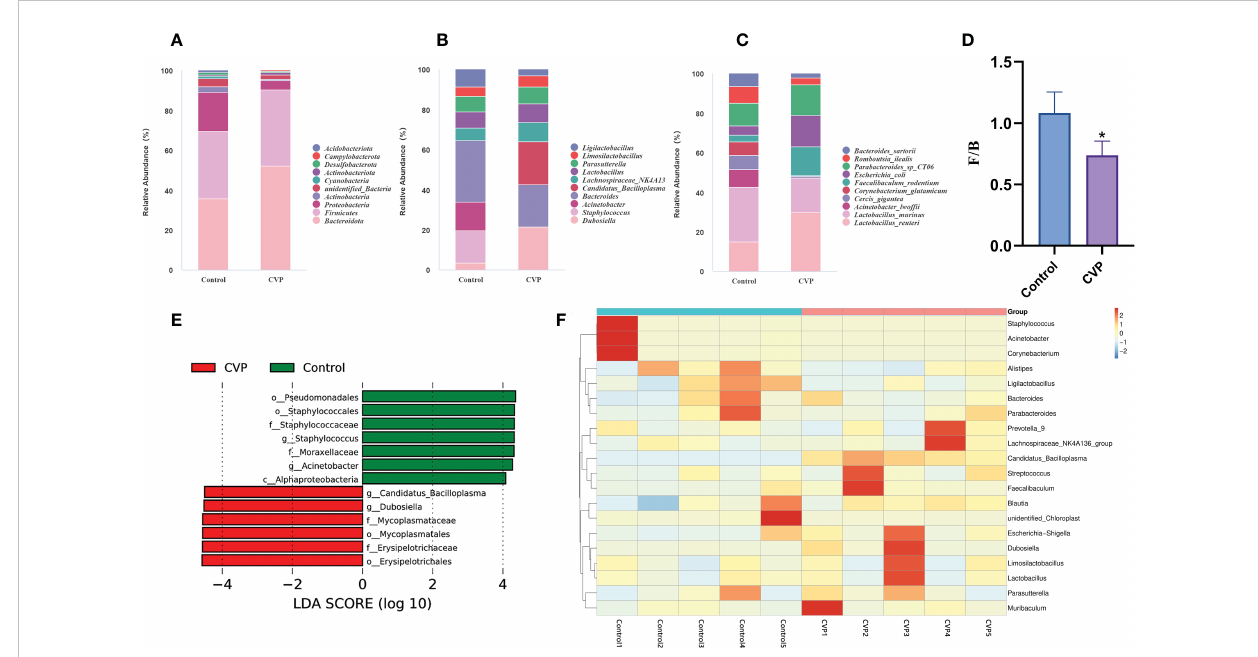
FIGURE 7 Comparative analysis of the effects of CVSS polysaccharide supplementation on the gut micro fl ora. (A-C) Relative abundance of species in the top 10 of the intestinal fl ora at the phylum, genus and species level; (D) Quanti fi cation shows the abundance ratio of Firmicutes/Bacteroidetes at the phylum level, n=5, “ * ” stands for the comparation with Control; * p <0.05 by one-way ANOVA; (E) The histogram of the distribution of LDA values shows the species with signi fi cant differences in abundance in different groups; (F) Heatmap depicting the relative abundance of 20 bacterial species signi fi cantly enriched in different samples at the genus